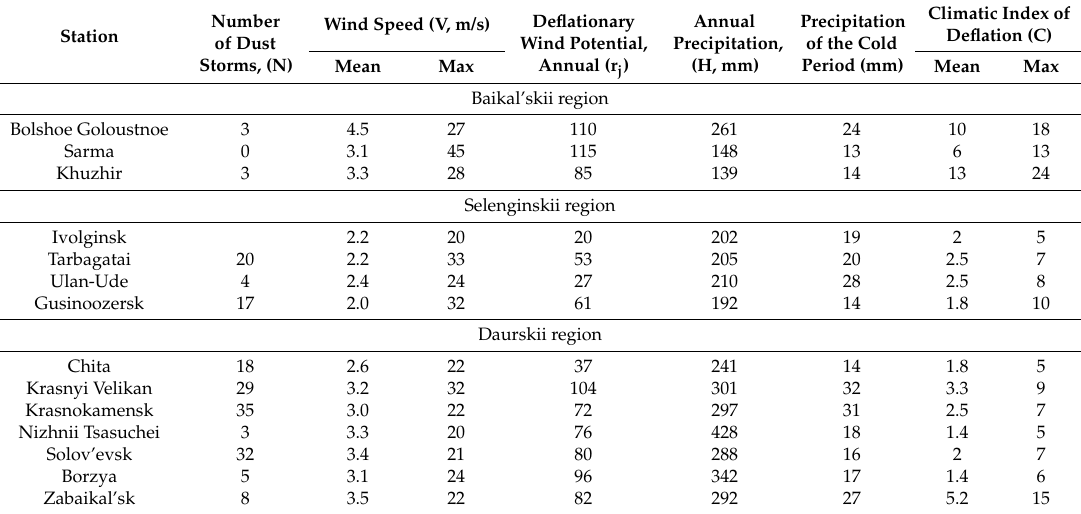
Table 1. Climatic indices that determine the intensity of matter